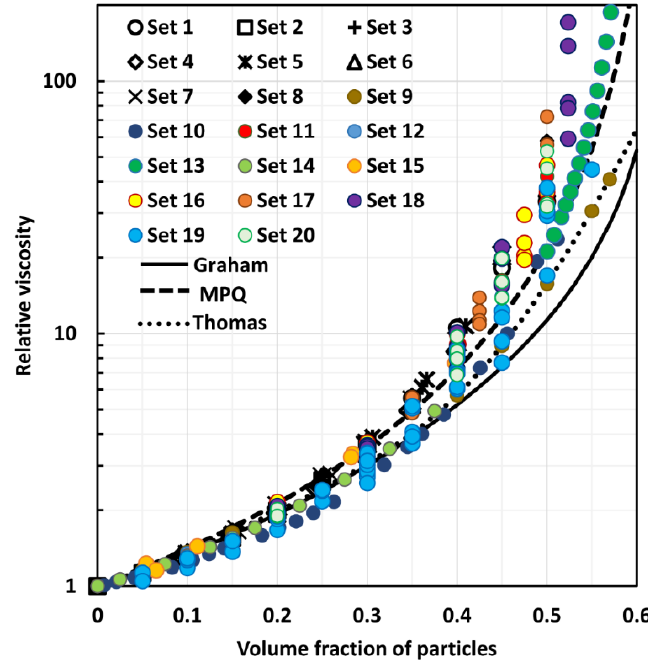
Figure 9. Comparison of experimental viscosity data for suspensions of non-Brownian hard spheres with the predictions of Graham, Thomas, and Maron-Pierce-Quemada (MPQ) models. φ m = 0.637 for the Graham and MPQ models.